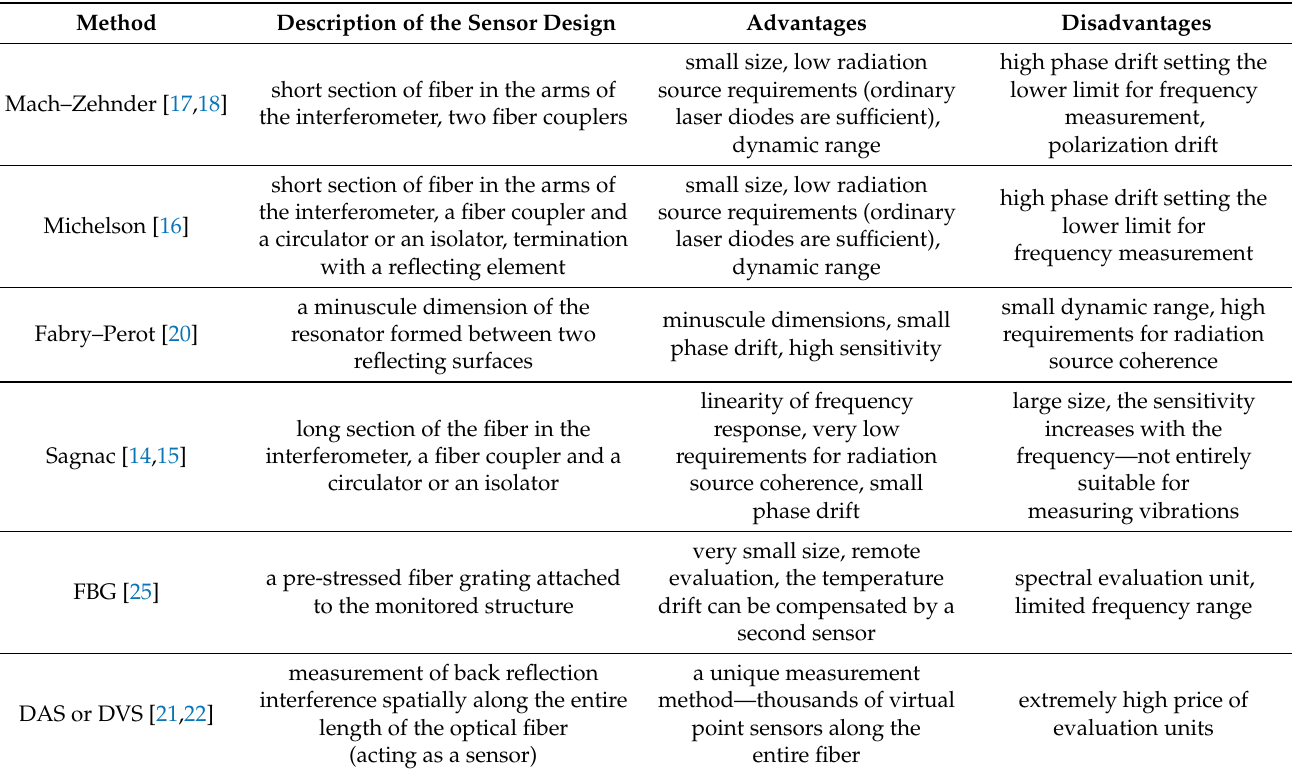
Table 2. Table of comparison of fiber-optic methods of vibration